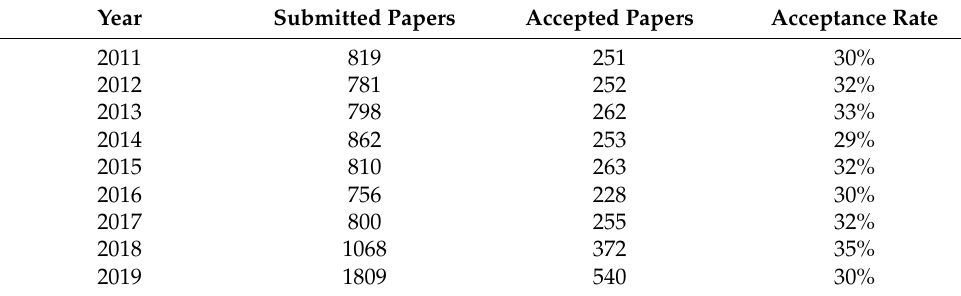
Table 1. MICCAI submission and acceptance data (main